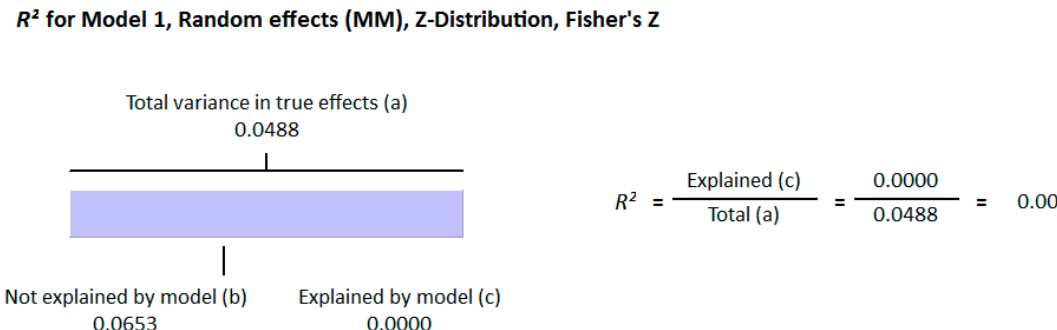
Figure 10. Forest plot for diabetic subject studies showing the correlation between status of vitamin D and fasting plasma insulin. The random effects model was used for the determination of correlation and 95% CI [18,53,77,107–109].